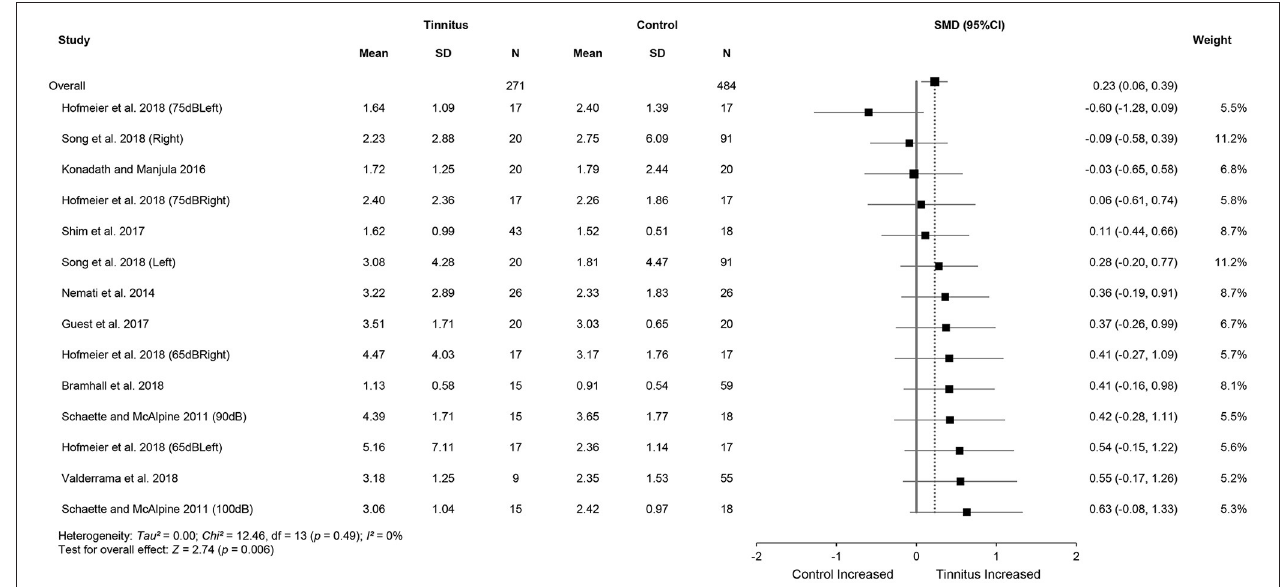
FIGURE 5 | Forest plot of nine studies for the difference of wave V/I amplitude ratios (95% CI) between tinnitus and control participants.